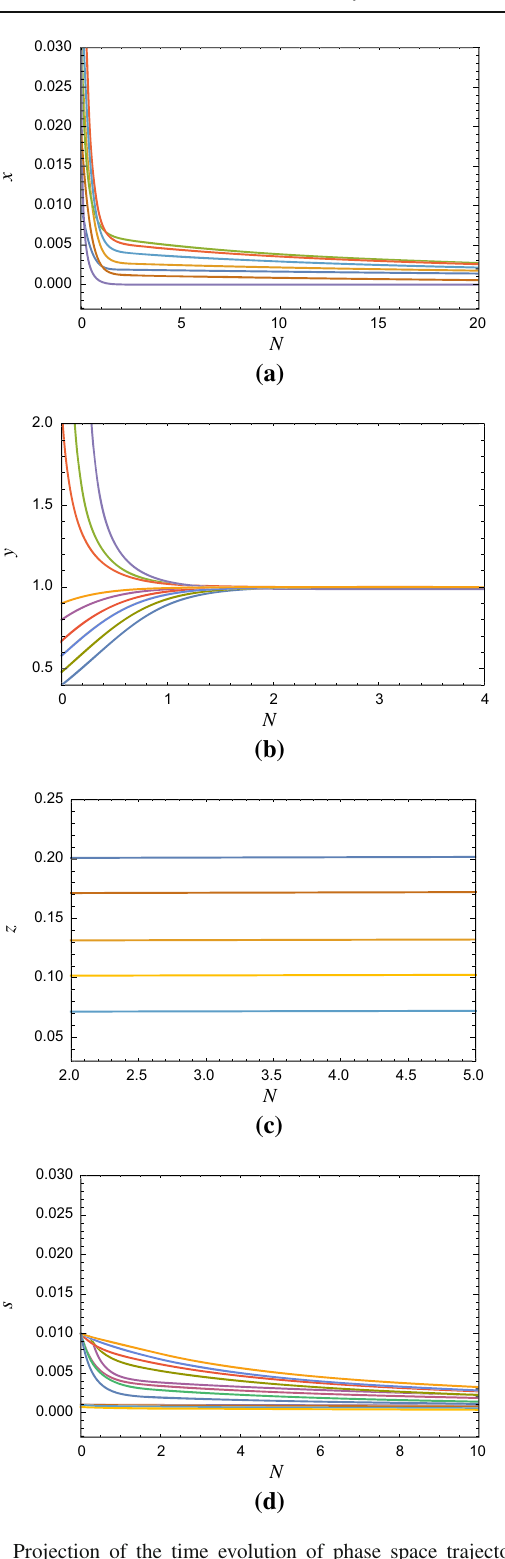
Fig. 6 Projection of the time evolution of phase space trajectories along the a x -axis, b y -axis, c z -axis and d s -axis which determine the stability of set E 2 . Here we take w = 0 and α = 1, V = V 0 φ − n with n = 4 and f (φ) = f 0 e βφ with β =